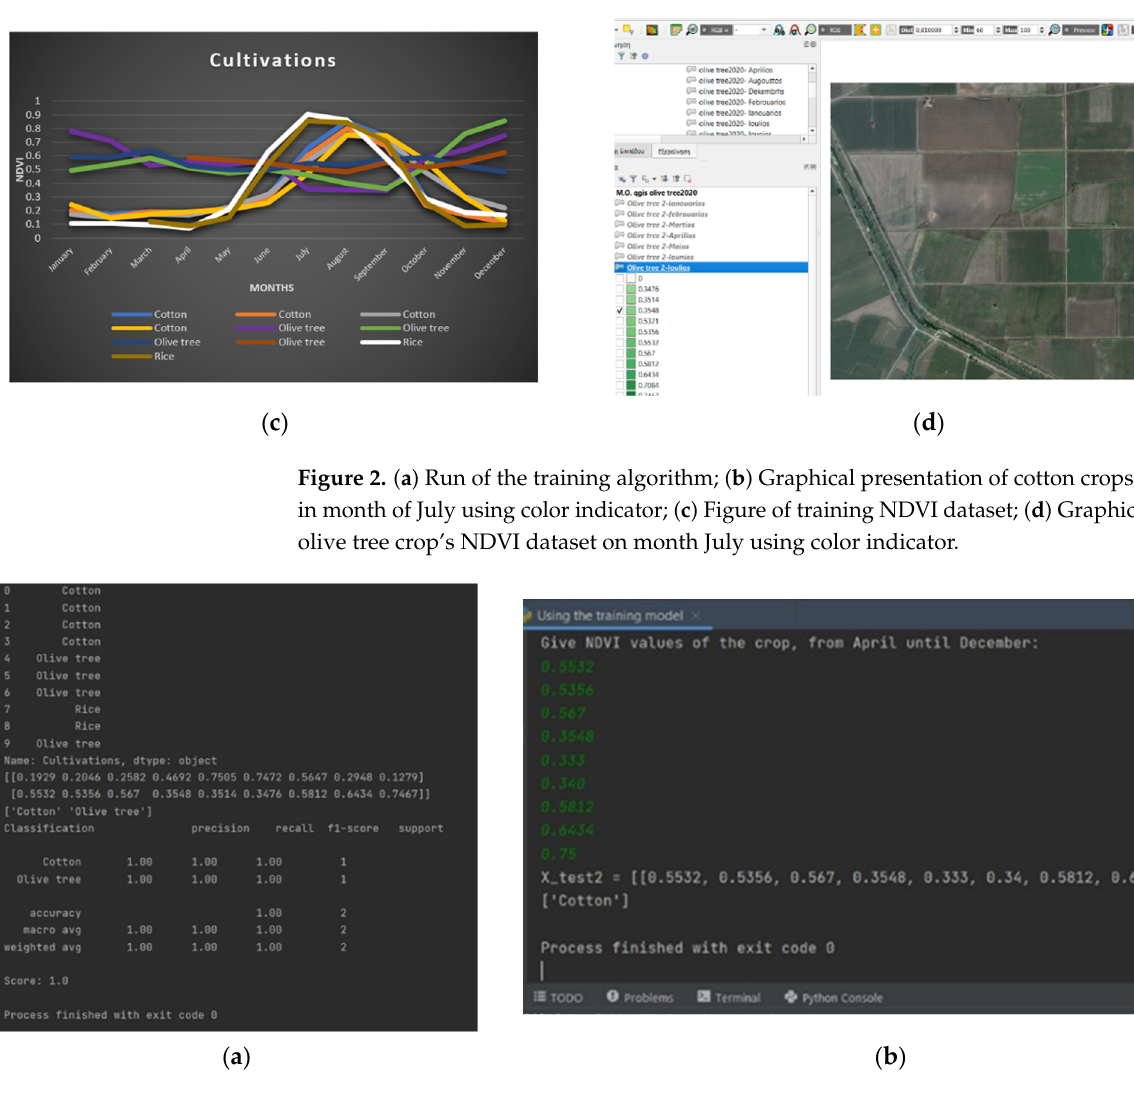
Figure 3. ( a ) Testing results by trained machine learning algorithm; ( b ) Input for the unknown crop’s NDVI values and identification prediction.